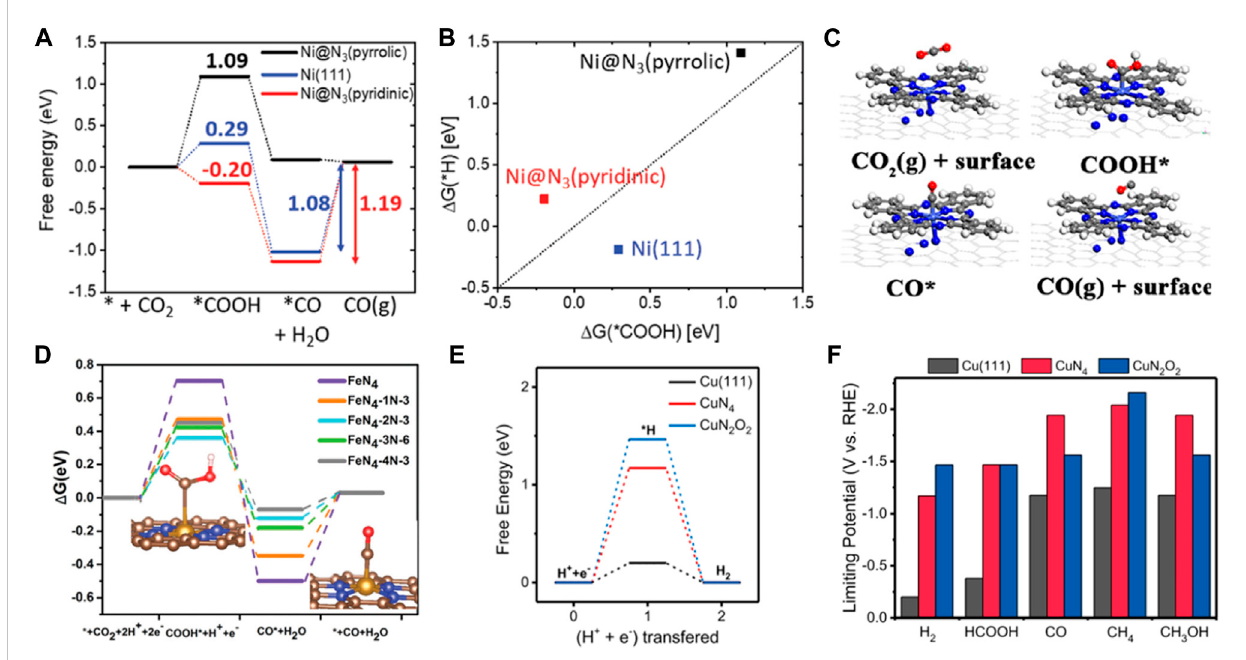
FIGURE 5 (A) Free energy diagram of electrochemical CO 2 reduction to CO on Ni@N 3 (pyridinic), Ni(111) and Ni@N 3 (pyrrolic). (B) The linear relationship between Δ G(*H) and Δ G(*COOH) ( fi gure used with permission from Sun et al., 2019) (C) Optimized structures of intermediates for CO 2 RR ( fi gure used with permission from Li etal., 2018) (D) Free energy diagram and intermediates geometries for electrochemical CO 2 reduction to CO on Fe – N 4 moieties embeddedoncarbonsheets.Gray,C;Orange,Fe;Blue,N;Red,O;lightwhite,H.(FigureusedwithpermissionfromTangetal.,2022) (E) Freeenergy diagram of hydrogen evolution on the CuN 2 O 2 (Cu-CDs), CuN 4 , and Cu(111). (F) The limiting potentials of the all products on the CuN 2 O 2 , CuN 4 , and Cu(111) ( fi gure used with permission from Zhu et al.,